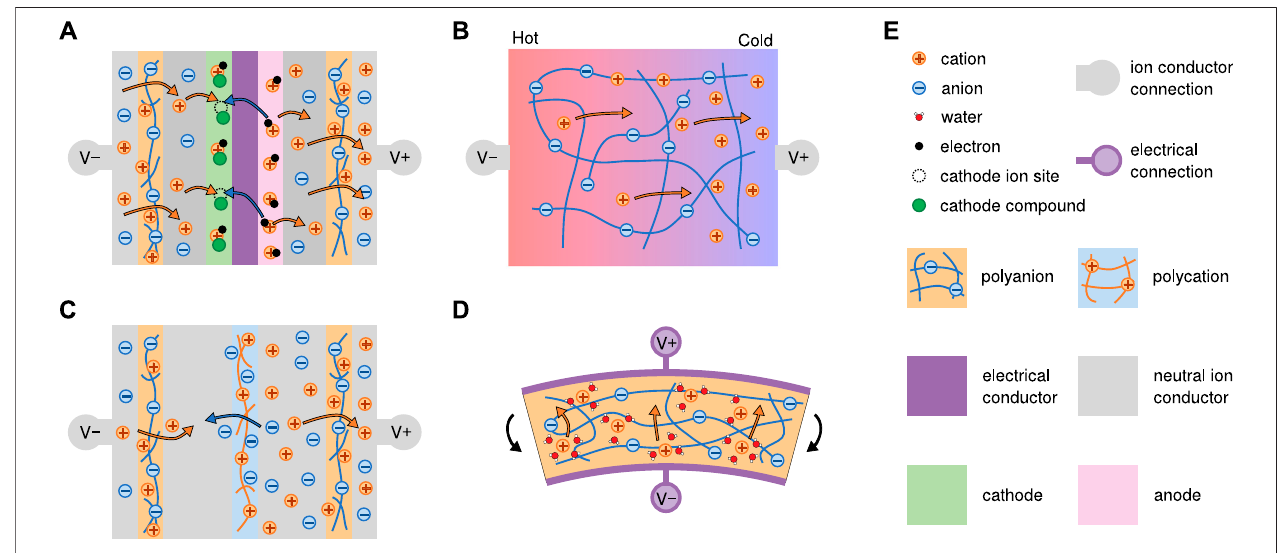
FIGURE 8 | Schematics of selected energy conversion approaches Video animations of parts A, C, and D are included in the Supplementary Materials for ease of visualization and on YouTube. (A) inverted battery with two ionic connections. Positive ions enter the device at the left and leave at the right. They are driven by the energydifferencebetweentheanodeandcathodematerial. (B) IonicThermoelectric.Aheatgradientfromhotonthelefttocoldattherightcausesmobilepositiveionsto travel towards the colder side of the device, increasing the electrochemical potential at the V + connection and decreasing it at the V − connection. (C) Reverse electrodialysis. The concentration difference between the right (initially salty) chamber and the left (initially salt-free) chamber drives mobile cations out the right V + connection, increasing the electrochemical potential there and decreasing it at the left V − connection. (D) Mechanical transducer (IPMC). The strain in the IPMC increases the pressureat the bottom ofthe device.This causessolvent tomigrateupward,and the binding between solvent and ionscarries positivemobile ions with it. Like the other energy devices, this increases the electrochemical potential at the V + connection. Unlike the other devices, this change in potential is usually captured by an electrical connection instead of an ionic one. (E) Legend for all